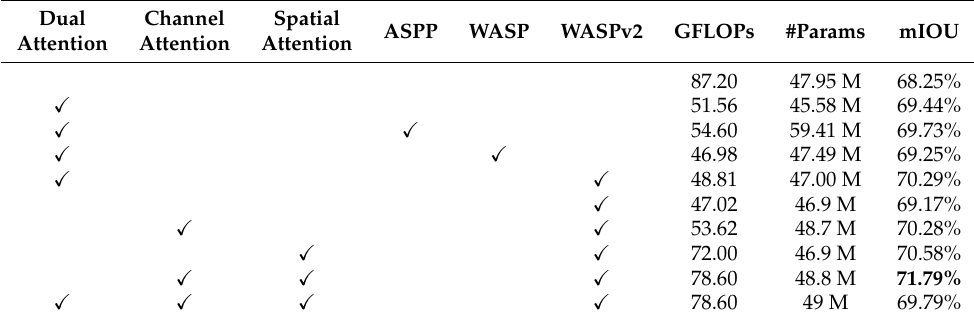
Table 1. Results of GourmetNet ablation experiments for various configurations on the UNIMIB2016 dataset. The segmentation accuracy is indicated by the mIOU score, while the model complexity is described by the number of parameters and GFLOPS.